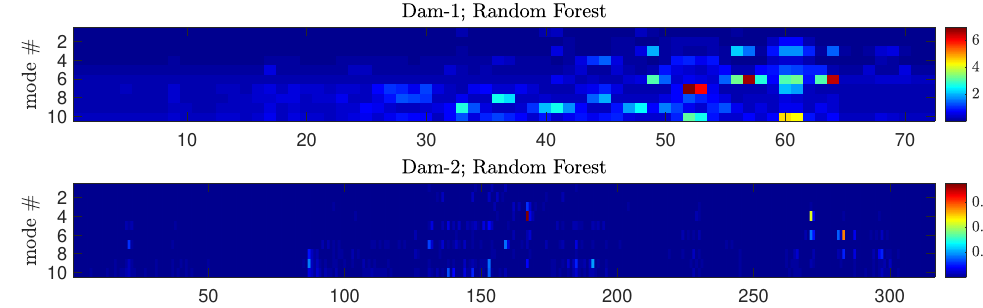
Figure 15. Estimation of variable importance using random forest for two dams and 10 modes.